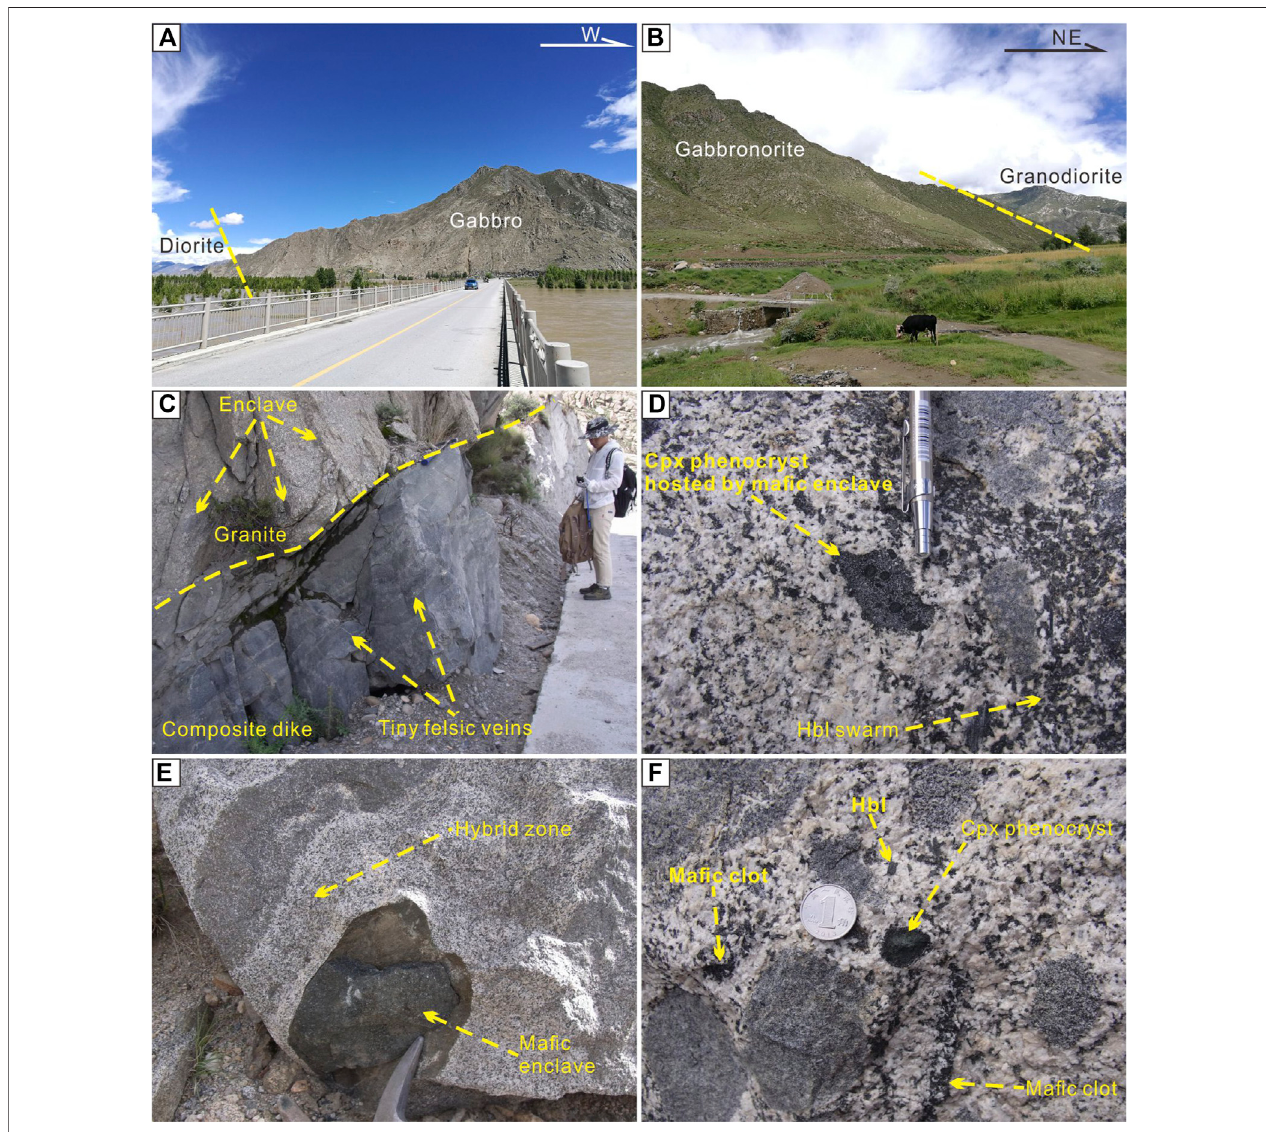
FIGURE4| Fieldphotosshowingthecontactbetweendifferentrocktypes. (A) ThecontactbetweenthegabbroandthedioriteinthesouthoftheQuxubridge. (B) The contact between gabbronorite and granodiorite in the town of Daga. (C) A ma fi c dike intruded into the crystallized monzogranite and cut by small scale felsic veins, formed during thelatest stageof hybridization. (D) A polygenic swarm ofenclaves, ma fi c to intermediate in composition. (E) The mixing zonebetween a ma fi c enclave and an intermediate enclave. (F) Polygenic swarm including intermediate enclave, ma fi c clots, and large clinopyroxene crystal.